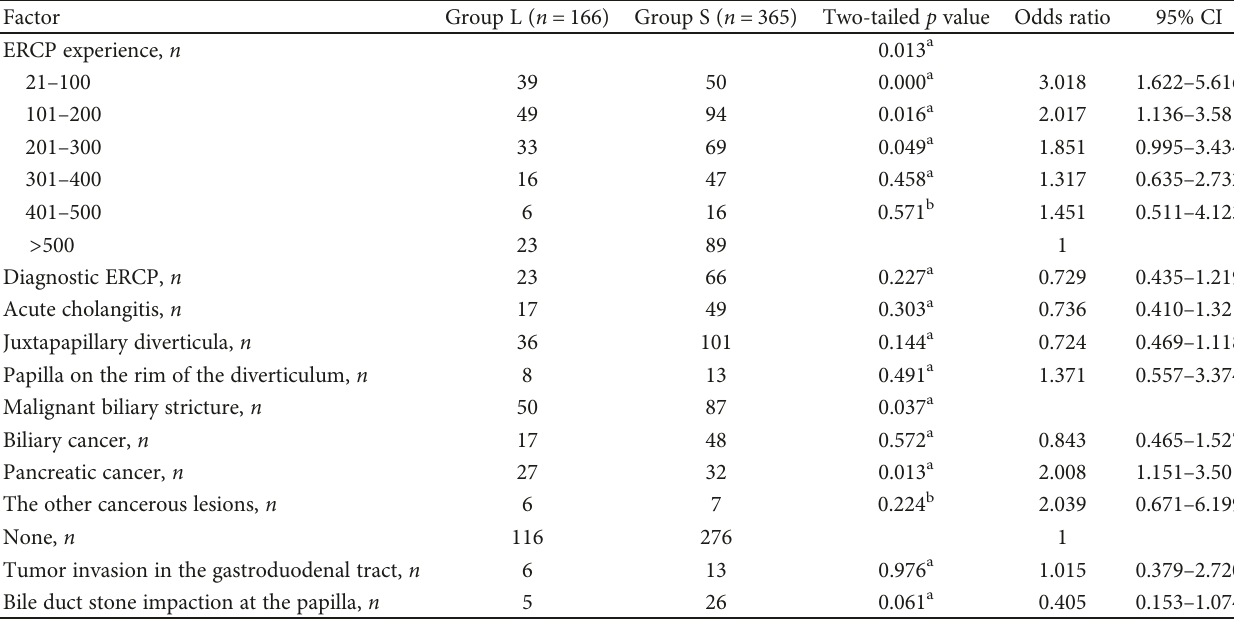
Table 2: Univariate analysis of the factors a ff ecting biliary cannulation